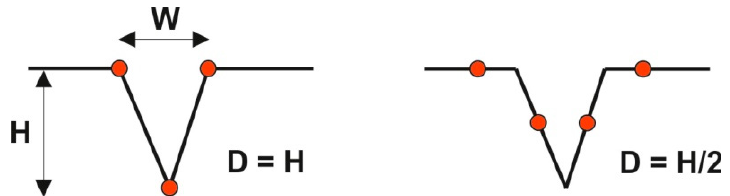
was proposed. valley